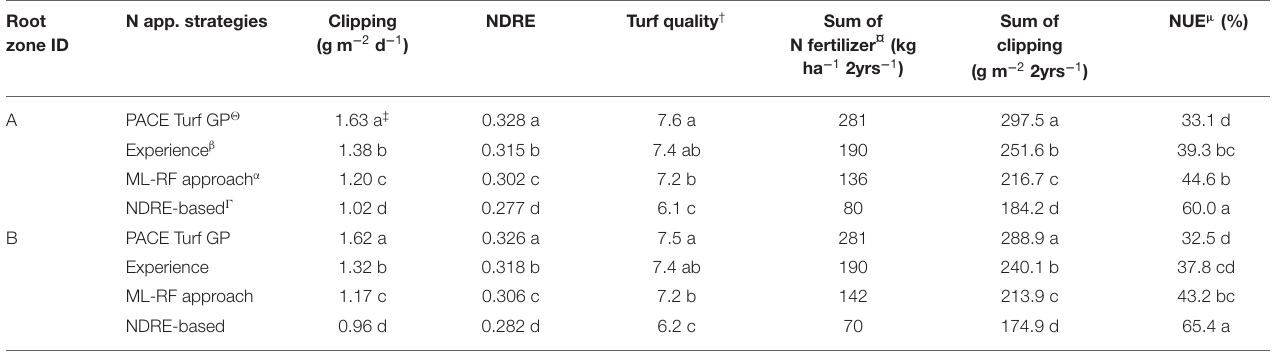
TABLE 2 | The 2-year mean creeping bentgrass clipping yield, NDRE, and turfgrass quality responses to four nitrogen (N) application strategies on two research putting greens. Root zone